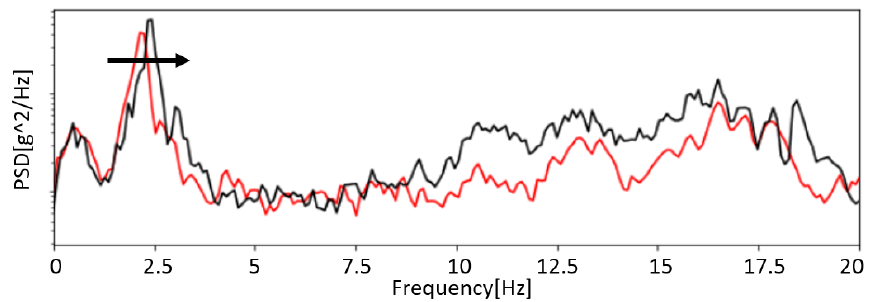
Figure 2. Mean natural frequency shift before and after scheduled